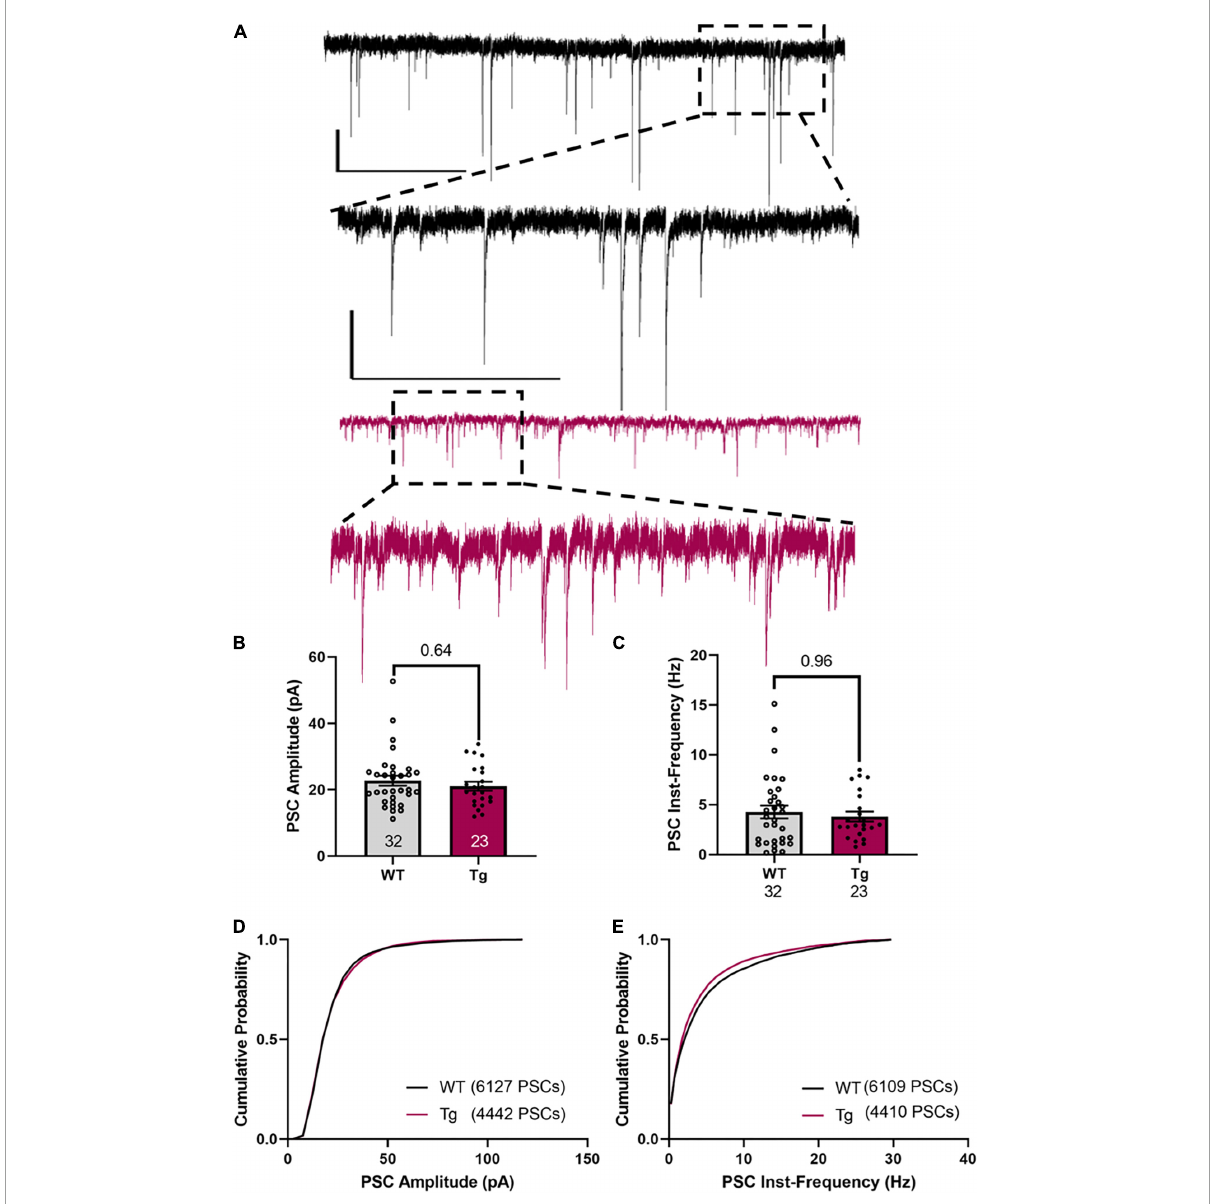
FIGURE5 sPSCs in CA1 neurons are not different between WT and Tg mice. (A) Representative traces of PSCs. Upper traces (black) are from a WT animal. The lower two traces (red) are from a Tg animal. The scale bars are 20 pA/5 s in the top trace and 10 pA/500 ms in the inset trace. These are the same for both genotypes. (B) The average amplitude is not different between the genotypes. (C) The instantaneous frequency between events is not different between the genotypes. Cell N is indicated at the bottom of histograms. (D) A cumulative plot of the amplitude of pooled sPSCs [6141 amplitude of sPSCs from 32 cells (WT), 4450 amplitude of sPSCs from 23 cells (Tg)] showing there is no statistical difference between WT and Tg ( p > 0.9, Kolmogorov-Smirnov Test). (E) A cumulative plot of the inst-frequency of pooled sPSCs [6109 inst-frequency of sPSCs from 32 cells (WT), 4427 inst-frequency of sPSCs from 23 cells (Tg)] showing there is no statistical difference between WT and Tg ( p > 0.8, Kolmogorov–Smirnov